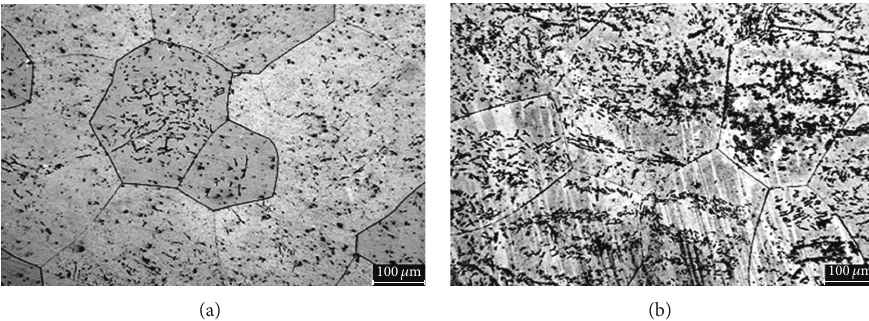
Figure 3: Metallographic microphotographs on (a) rolling surface and (b) long transverse side of B0 sheets.